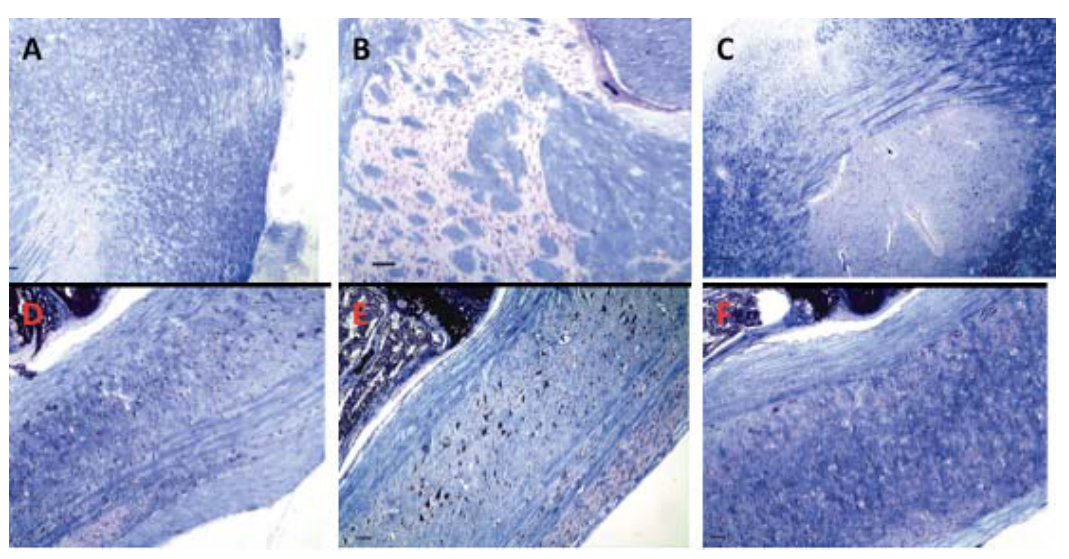
Figure 8. No evidence of demyelination is observed in brain or spinal cord of treated animals. CMP 106 ( A,D ); CMP 107 ( B,E ); Control ( C,F ). Luxol fast blue, 100× magnification, bar equals 100